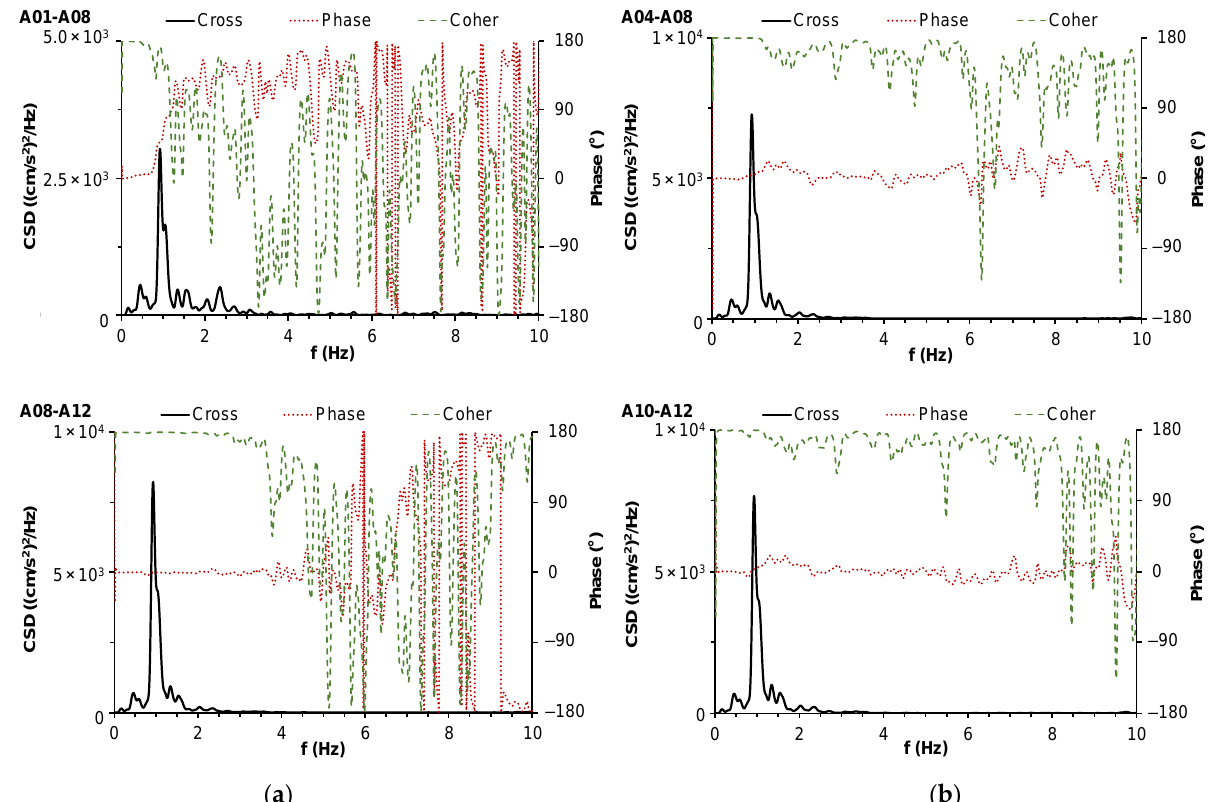
Figure 9. CSD of sensors in x direction ( a ) at different levels and ( b ) at the same level (the coherence varies in [0,1]).